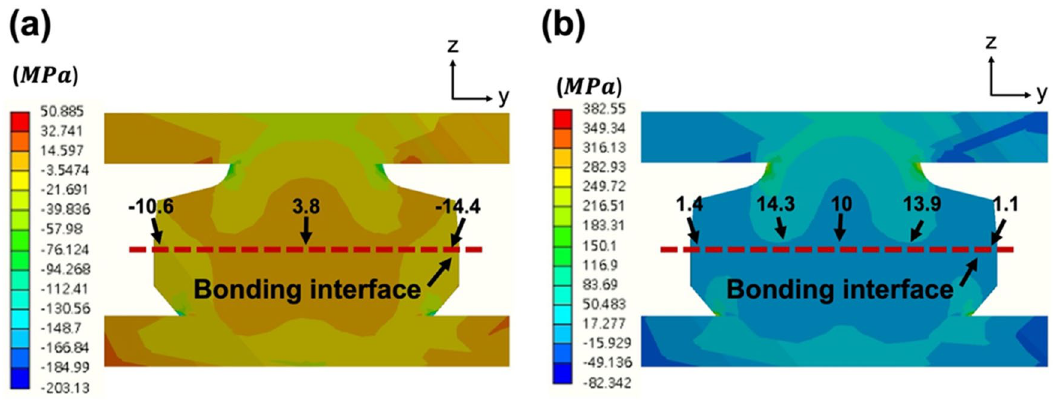
Figure 10. Stress distributions in the 3D FEA model at ( a ) − 55 °C and ( b ) 125 °C. The red dotted lines illustrate the bonding interfaces. The maximum and minimum stresses in the bonding interfaces are indicated by the black